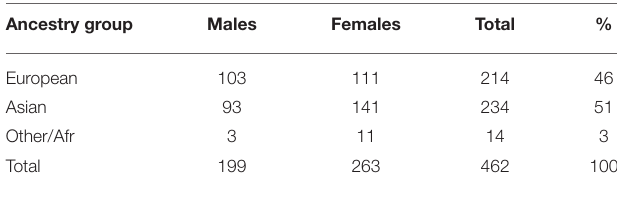
TABLE 1 | Gender of 462 CP cases in the international consortium study by ancestral group.